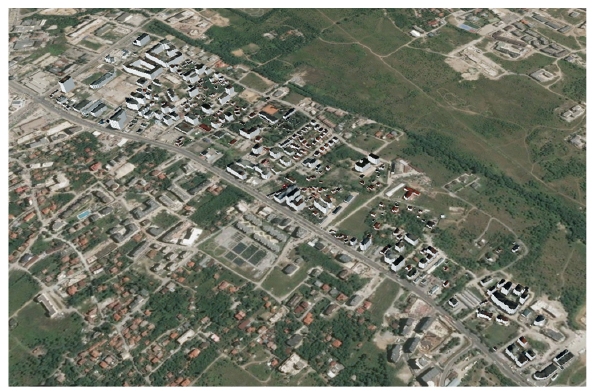
Figure 13. The CityGML model in Cesium Ion.